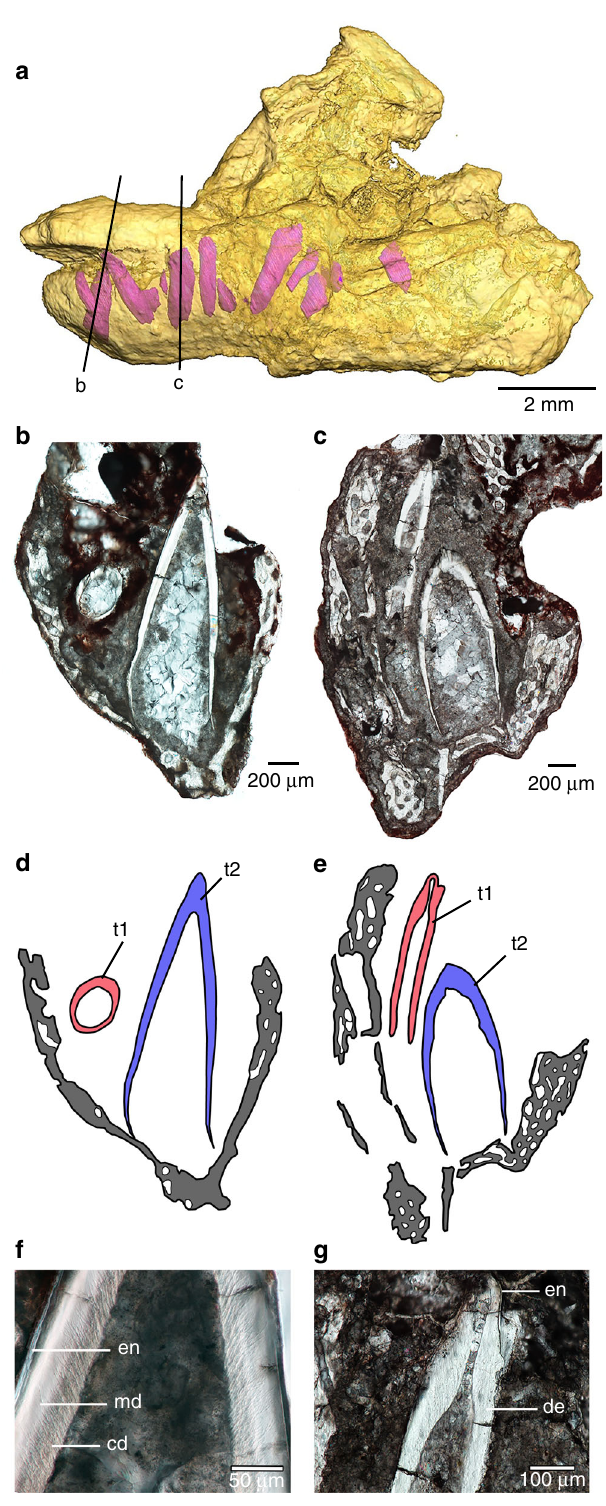
the older tooth, the replacement teeth develop lingually, gradually migrate beneath the functional tooth, and eventually cause apical root resorption and tooth shedding (Fig. 4d, e) 14 .